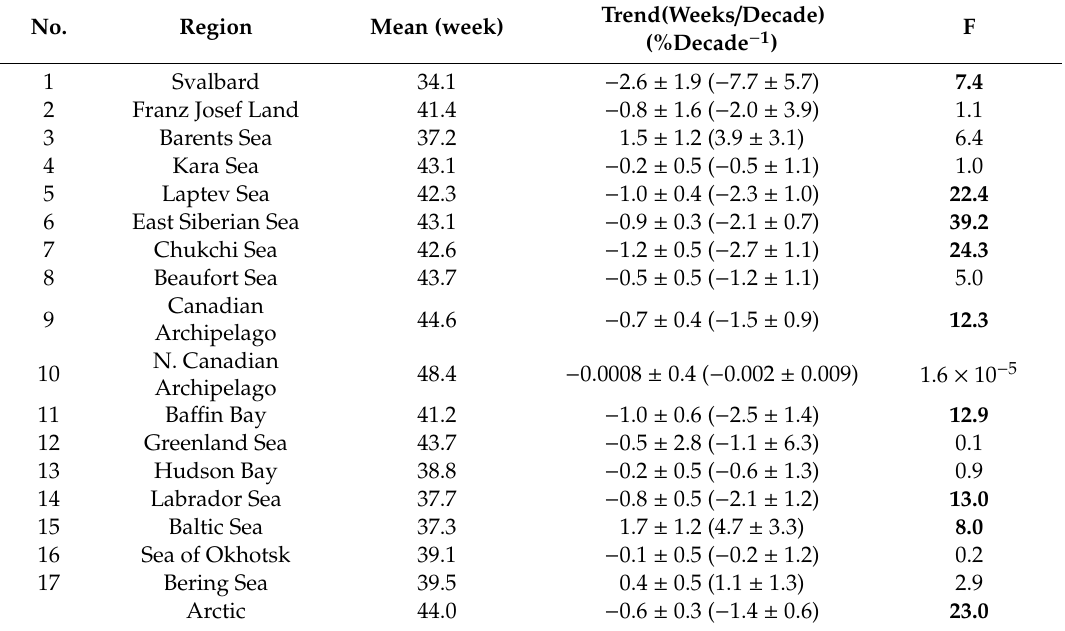
Table 3. Landfast ice duration in 17 regions and the entire Arctic during 1976–2018. The F-test is used to determine the significance of the trend independent of the statistical data, and bold numbers indicate that the trends are significant at the 0.01